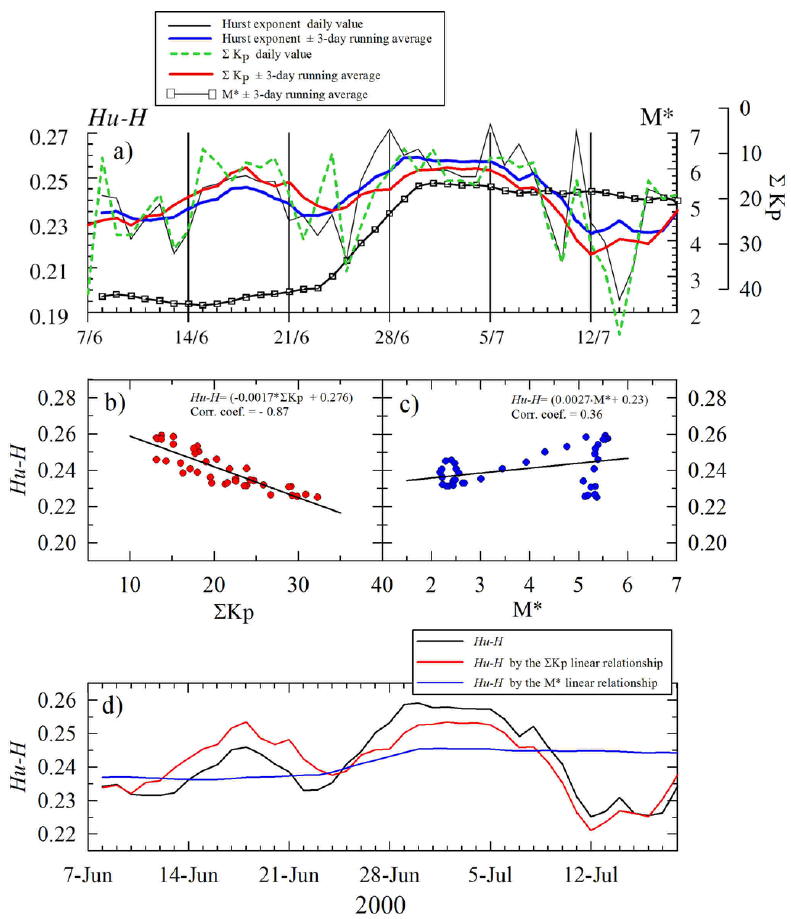
Fig. 3. (a) A reproduction of Fig. 2 by Hayakawa et al. (2004). Variation of the Hurst exponent (daily values and ± 3-day running average) of the geomagnetic field H component at the time of the Izu swarm. The ± 3-day running average of earthquake magnitude M ∗ (solid line with open squares) is also shown. 6 Kp time series (daily values and ± 3-day running average) have been superimposed onto the original view. (b) and (c) linear relationships between the ± 3-day running average of the Hurst exponent and 6 Kp and M ∗ , respectively. (d) the Hurst exponent calculated by Hayakawa et al. (2004) compared with reconstructed Hurst exponents using the linear relationships shown in panels (b) and (c) . See text for